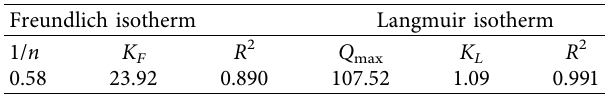
Table 1: Adsorption isotherm constants of RBB adsorption onto the